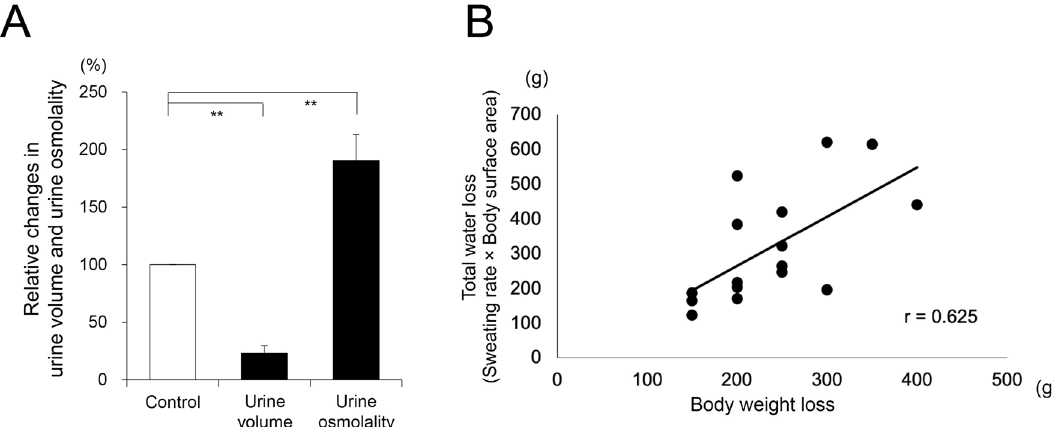
Figure 5. ( A ) Comparison of relative changes in the urine volume and urine osmolality (ordinate) before physical exercise and 30 min after the exercise (n = 16, ** p < 0.01). ( B ) Relationship between sweating-mediated water loss and decreased body weight during physical exercise. The total water loss is 269.9 ± 34.3 g (n = 16). The decreased body weight is 262. 5 ± 34.9 g (n = 16). Male Female Sweating rate × Body No BMI (kg/m 2 ) surface area (g) Body weight loss (g) BMI (kg/m 2 )